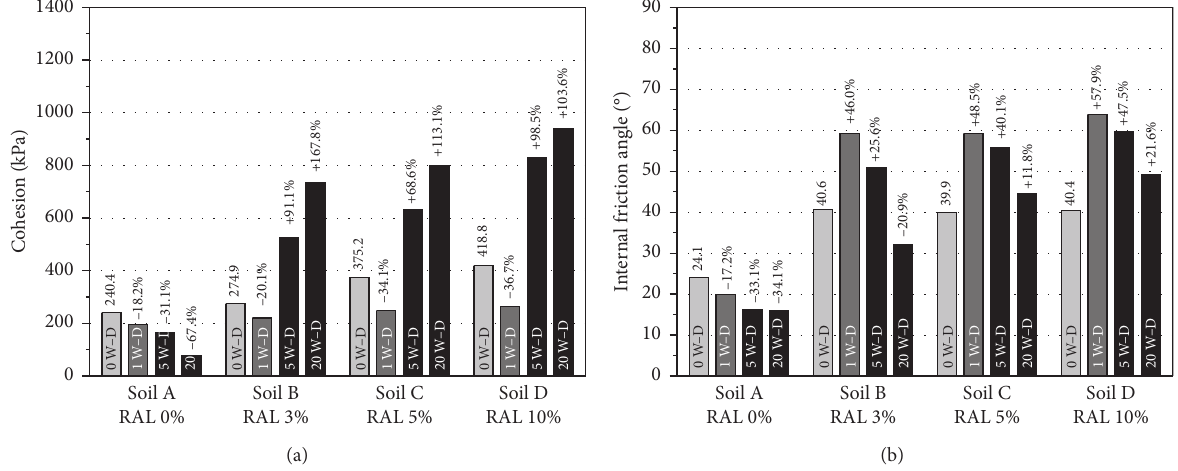
Figure 5: Variations in the shear strength parameters of the untreated and lime-stabilized specimens with the W-D cycles: (a) cohesion; (b) internal friction